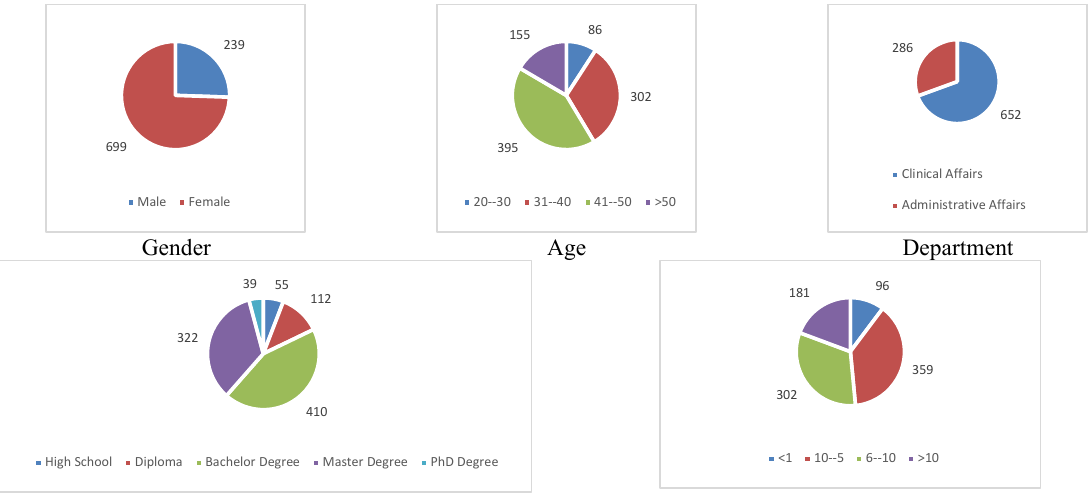
Fig. 2. Characteristics of